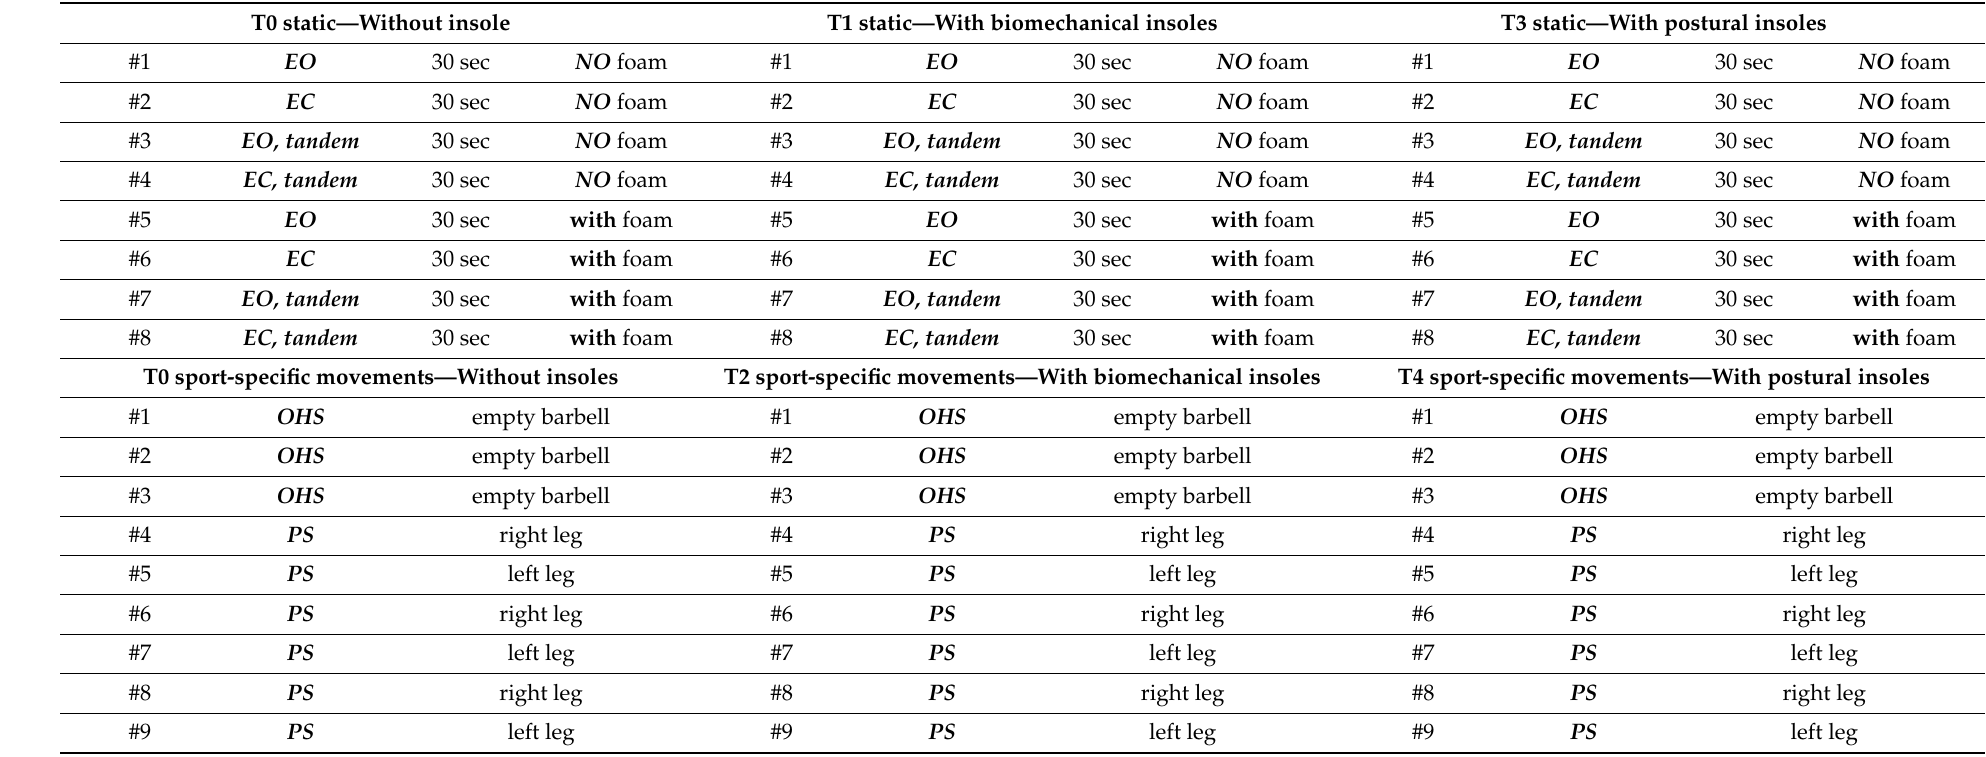
Table 3. Description and flow diagram of testing